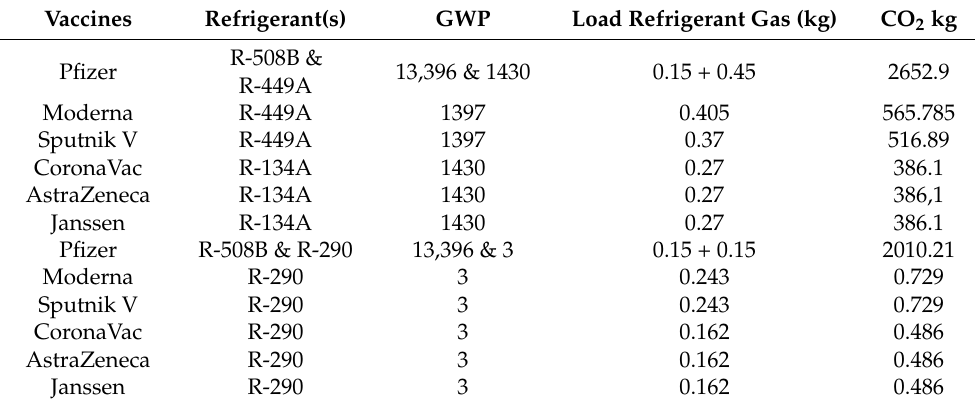
Table 6. Vaccines, refrigerants, and GWP.